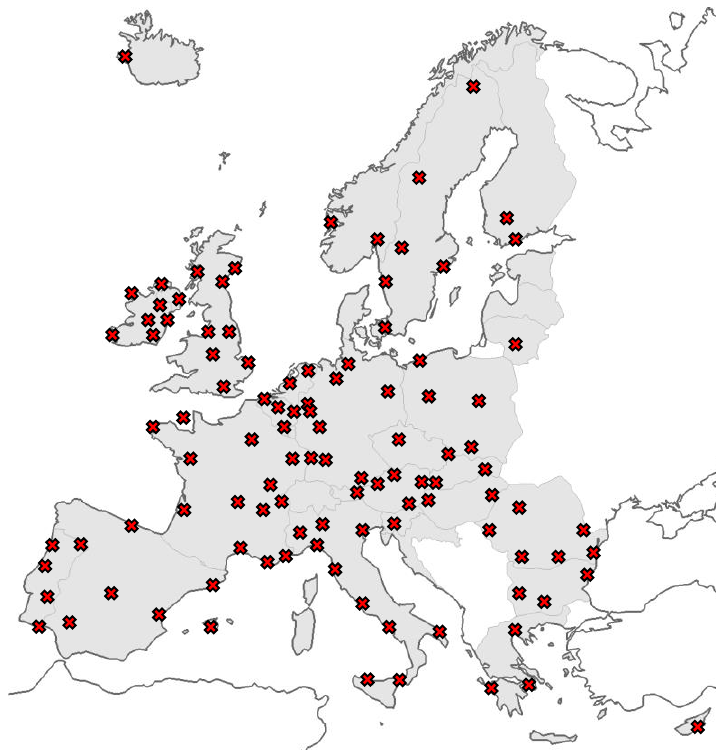
Figure 5. Analysed